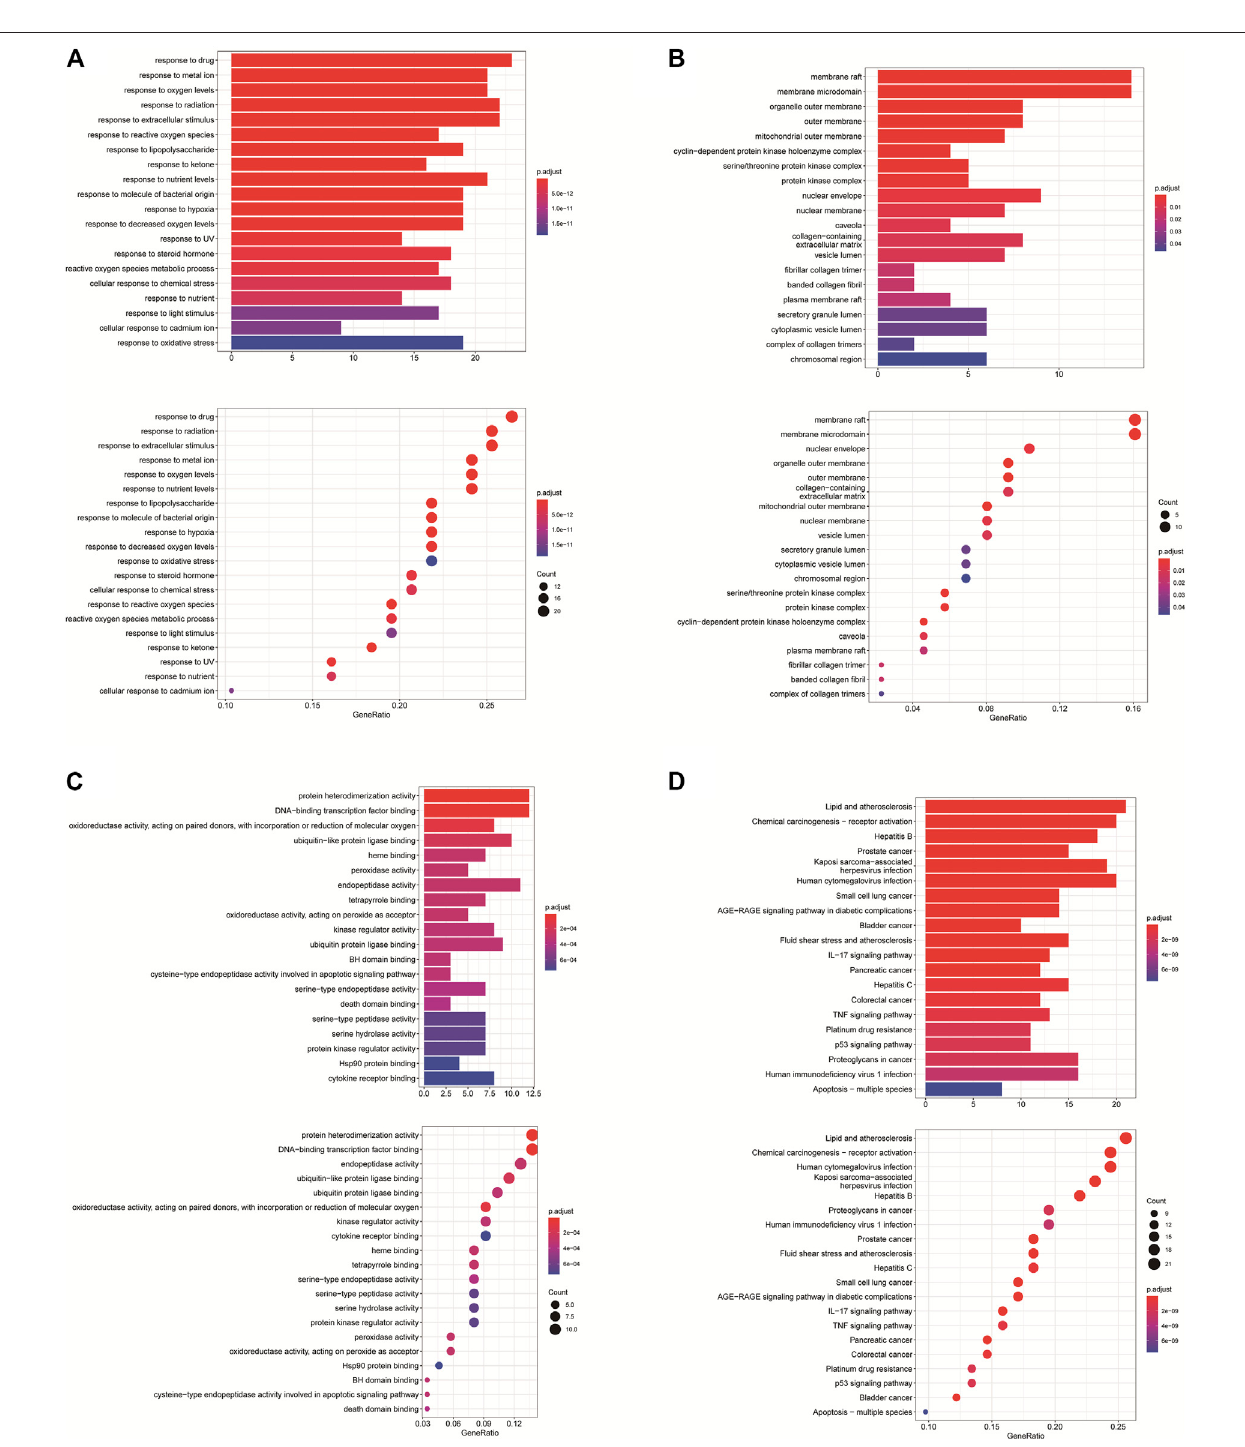
FIGURE 4 | Enrichment analysis of Gene Ontology (GO) and Kyoto Encyclopedia of Genes and Genomes (KEGG) pathway biological process of anticolorectal cancer targets gene from active ingredients of PM . The color scale indicates the p value, and the dot size indicates the gene count in each term. (A) GO analysis of multicellular organismal development (BP), mitotic G1 DNA damage checkpoint, G1 DNA damage checkpoint, and mitotic G1/S transition checkpoint were screened out. (B) GO analysis of intracellular membrane-bounded organelles (CC), cyclin-dependent protein kinase holoenzyme complex, serine/threonine kinase complex and protein kinase complex were screened out; (C) GO analysis of protein binding (MF). (D) KEGG analysis, CXCR chemokine receptor binding, and sulfur compound binding were screened out.